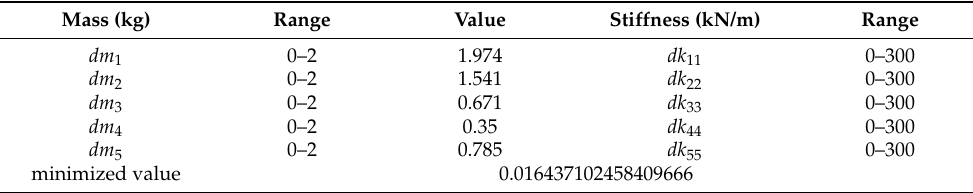
Figure 18. Modified structure after the simultaneous addition of masses and supporting stiffness. Table 11. Parameters of added masses and supporting stiffness.